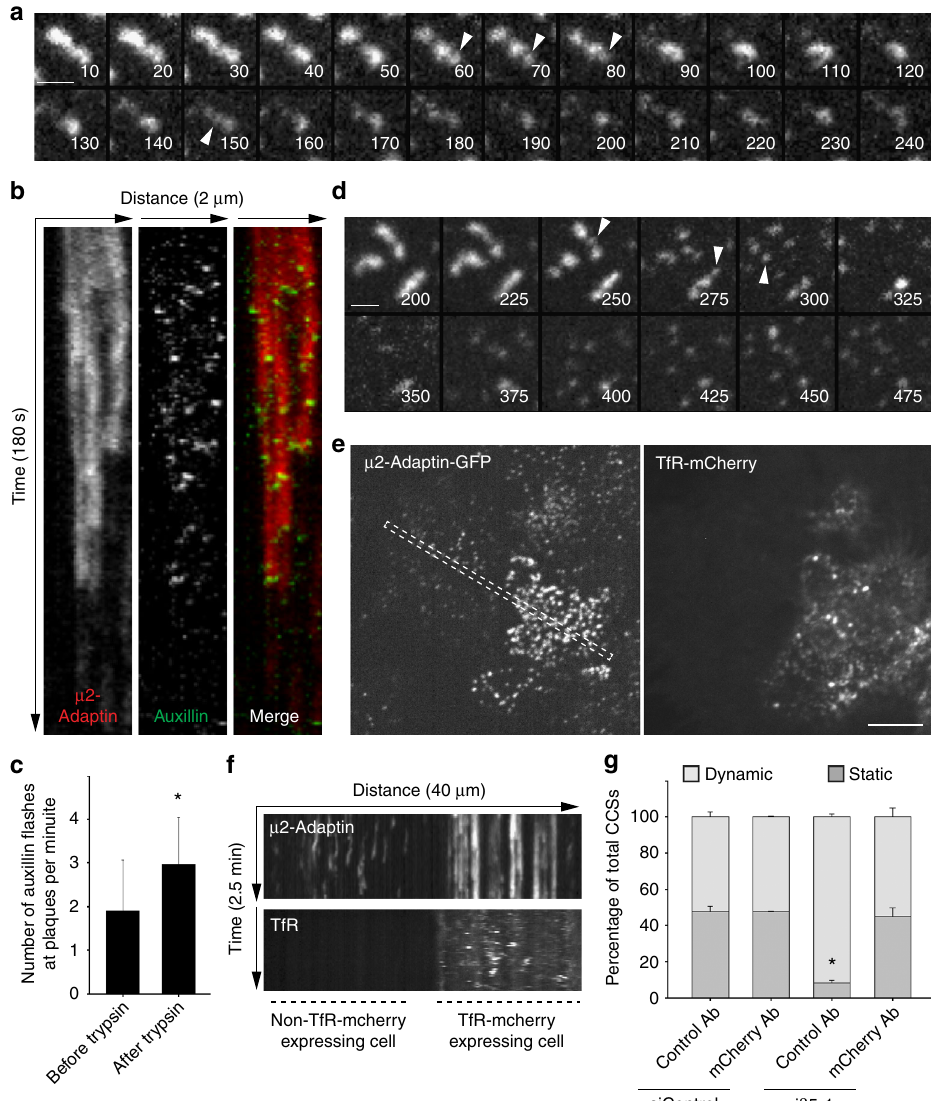
Fig. 3 Clathrin-coated plaques assemble as a consequence of frustrated endocytosis. a Genome-edited HeLa cells expressing endogenous mCherry-tagged μ 2-adaptin, seeded on collagen-coated glass, were treated with trypsin and imaged by spinning disk microscopy every 5 s. Time after trypsin addition is indicated in seconds. Arrowheads point to dot-like structure emanating from the disassembling plaques. Scale bar: 1 μ m. b Kymographs showing plaque disassembly dynamics and concomitant GFP-auxillin bursts in HeLa cell treated and imaged as in a . Note that loss of μ 2-adaptin-associated fl uorescence is correlated with auxillin fl ashes. c Quanti fi cation of the number of auxillin fl ashes per plaque and per minute in HeLa cells before and after incubation with trypsin. Results are expressed as mean ± SD (* P < 0.001, Mann – Whitney rank sum test. A total of 90 structures from three independent experiments was quanti fi ed). d Genome-edited HeLa cells expressing endogenous mCherry-tagged μ 2-adaptin, seeded on collagen-coated glass, were treated with Cilengitide and imaged by spinning disk microscopy every 5 s. Time after Cilengitide addition is indicated in seconds. Arrowheads point to dot-like structure emanating from the disassembling plaques. Scale bar: 1 μ m. e Genome-edited HeLa cells treated with β 5-speci fi c siRNA and transfected with a construct encoding mCherry-tagged TfR were seeded on anti-mCherry antibodies-coated glass and imaged 24 h later by spinning disk microscopy every 5 s. Scale bar: 10 μ m. f Kymograph showing CCS dynamics in the region corresponding to the boxed area in e . Note that the cell on the left is not transfected by the TfR-mCherry construct and only display dynamic CCSs. g Quanti fi cation of the dynamics of CCSs observed as in e in genome-edited HeLa cells expressing the TfR-mCherry construct and treated as indicated (* P < 0.001, one-way analysis of variance — ANOVA. n = 3). Results are expressed as mean ±